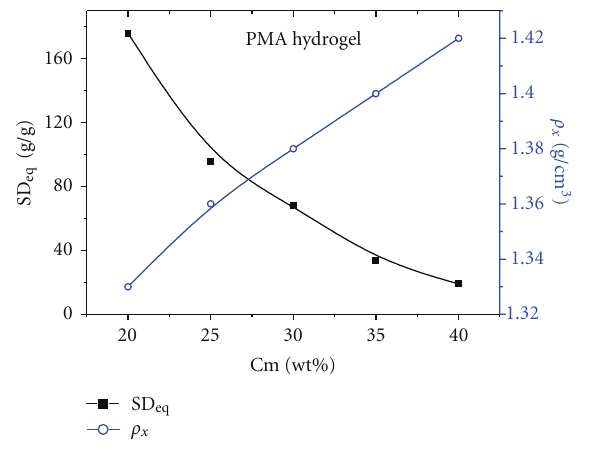
Figure 5: E ff ect of monomer concentration on macroscopic properties for PMA xerogels.